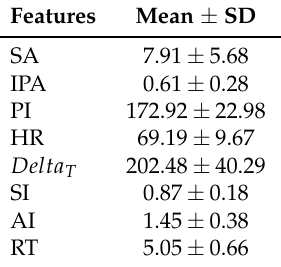
Table 1. PPG feature mean ( ± Standard Deviation (SD)) of the PPG endothelial dysfunction dataset (ppgEDD).